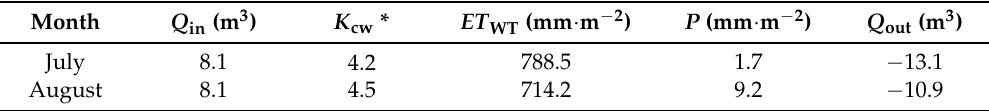
Table 2. HF-CW water balance (27 m 2 ) in July and August.